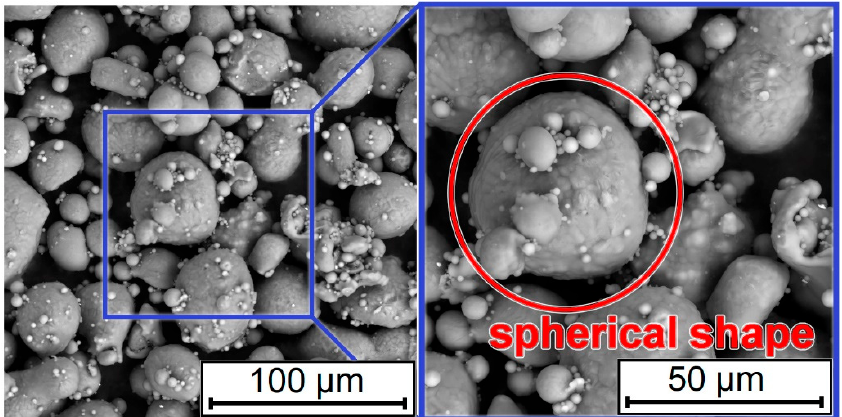
Figure 6. SEM images of ASP-30 powder after classification.